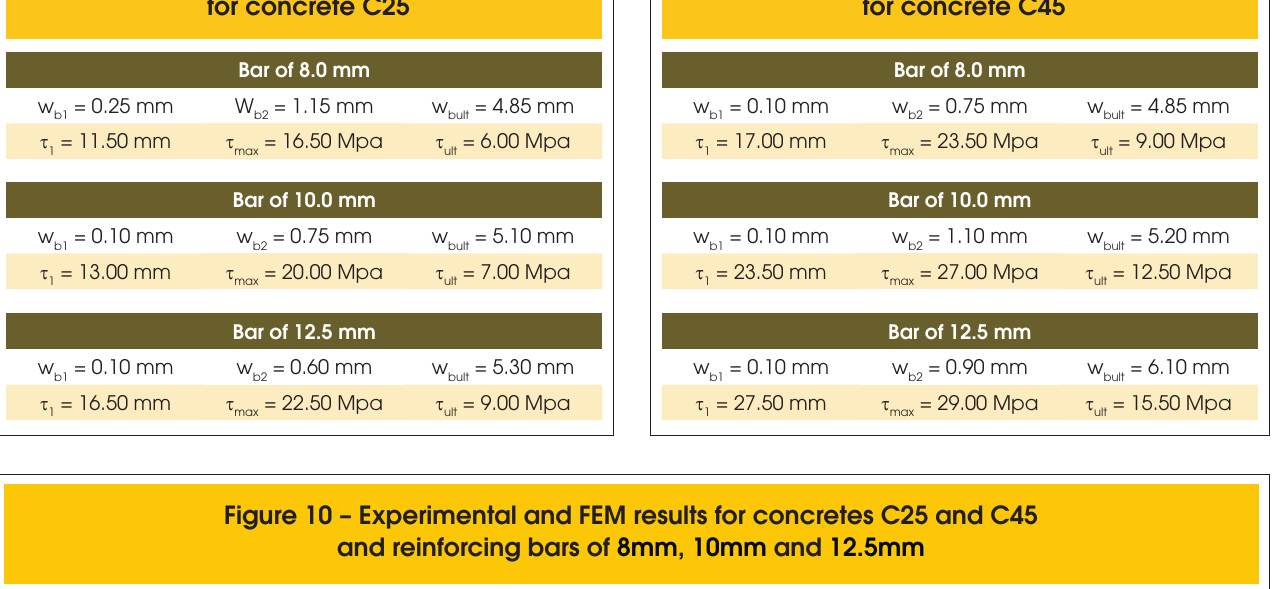
Table 7 – Parameters for the Hawkins bond law for concrete C45